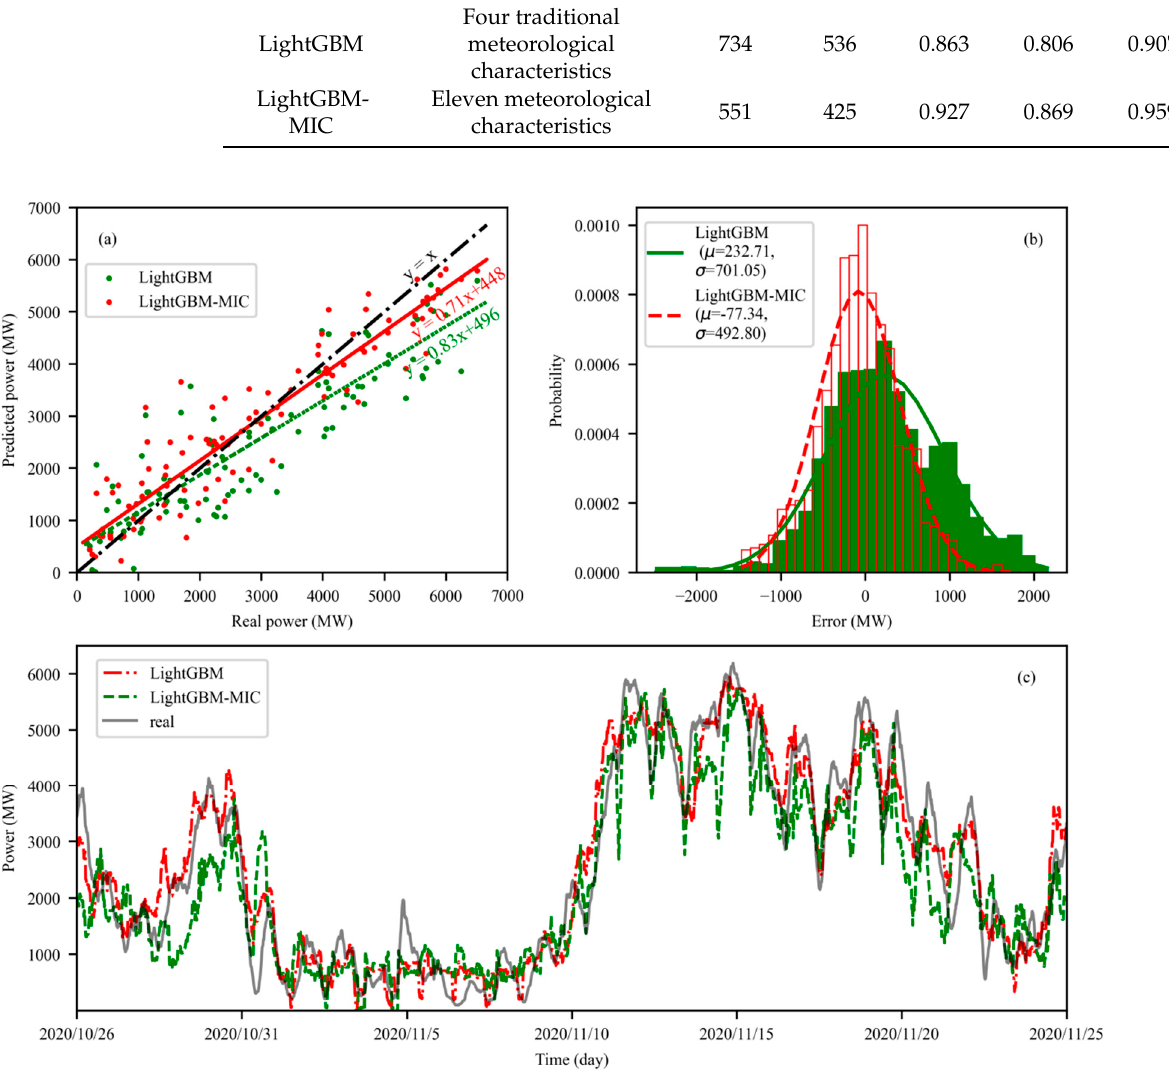
Figure 7. The power forecasts of LightGBM and LightGBM − MIC for the testing set (26 October 2020–25 November 2020, 30 days). ( a ) Real versus forecasted output. ( b ) The histogram of the pre- diction error of the testing set. ( c ) Comparison of the real and forecasted output. Table 7. Comparison of prediction accuracy of different meteorological